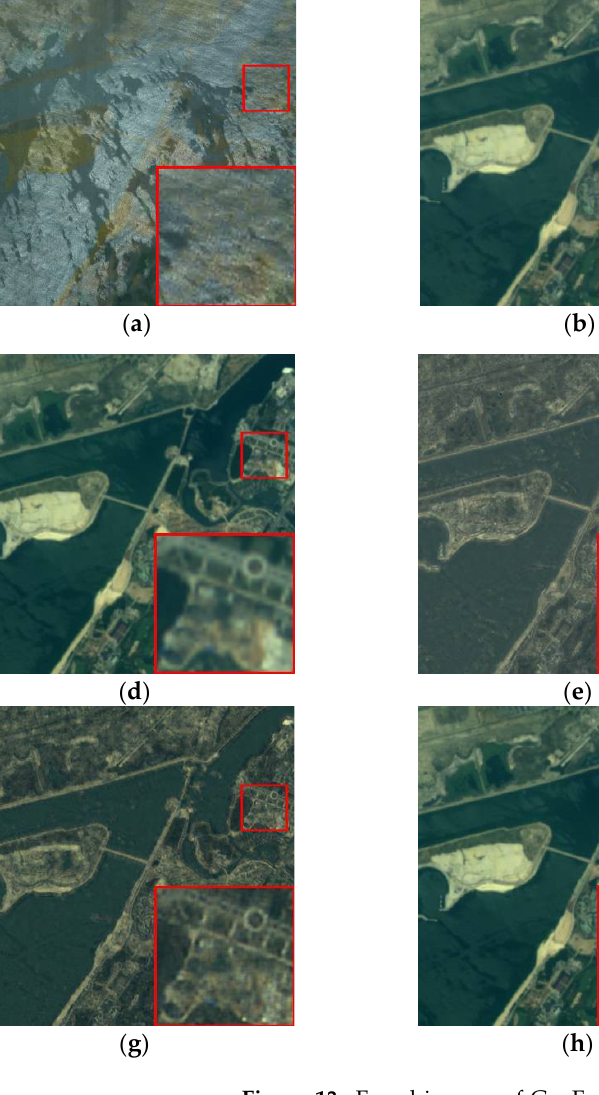
Table 8. Quantitative evaluation comparison of real data experiments on three datasets. The values in bold represent the best result .